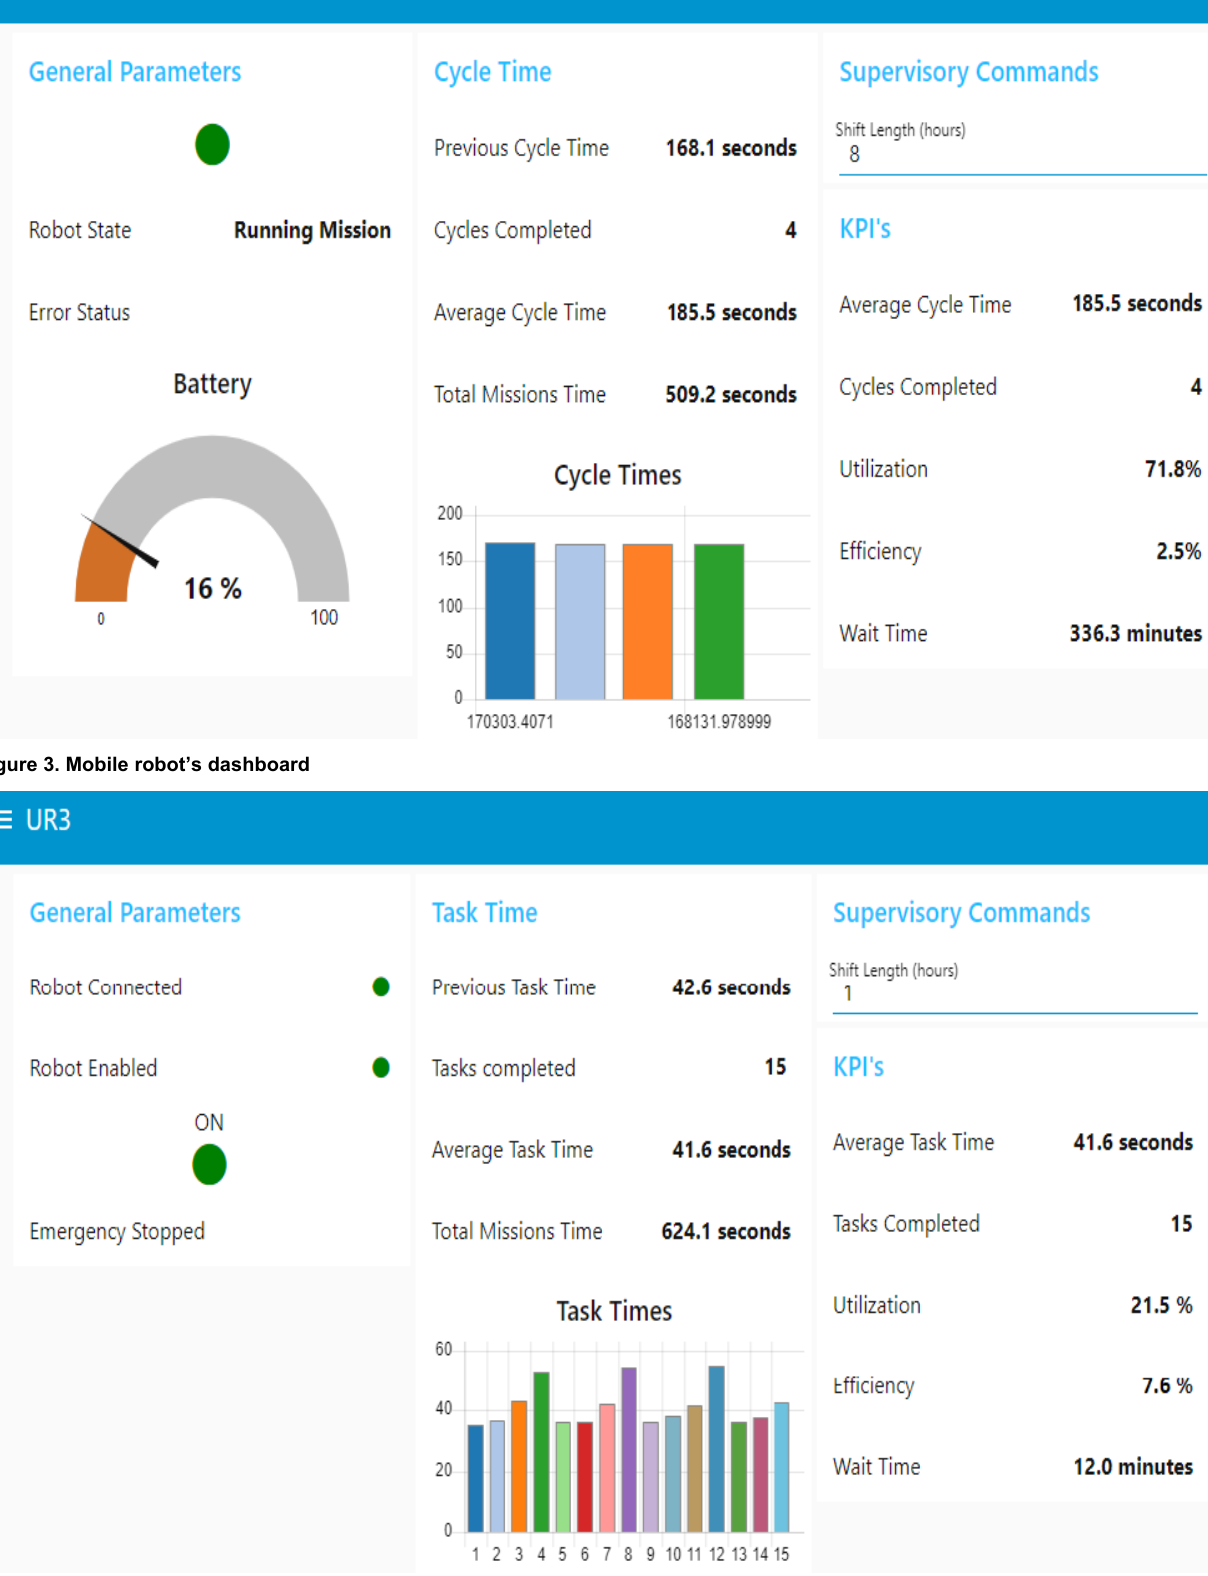
Figure 4. Manipulator’s